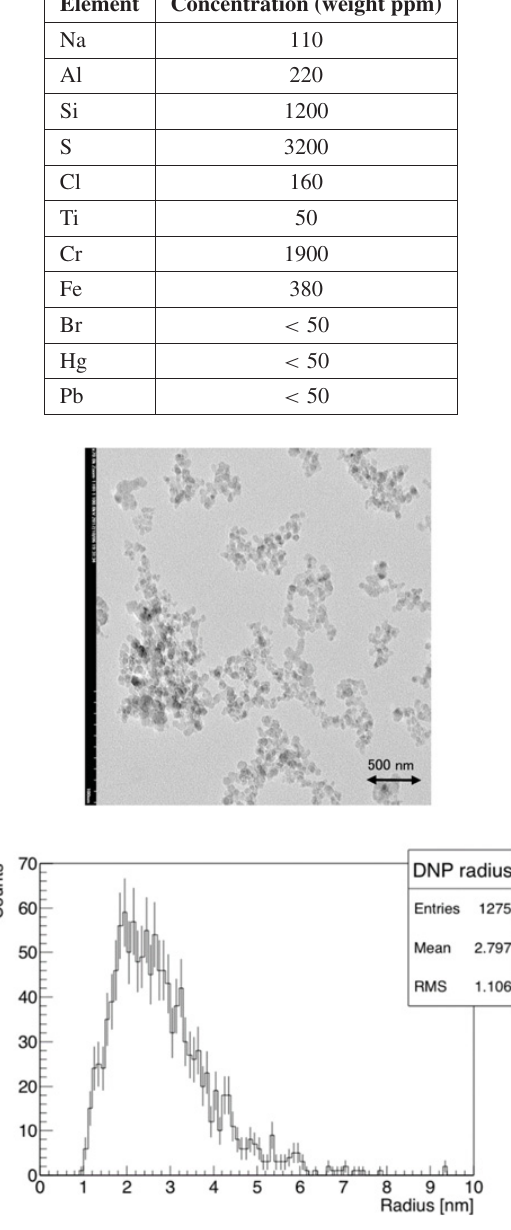
Figure 2. TEM image of the DNP sample material (top). Particle radius distribution deduced from this TEM image